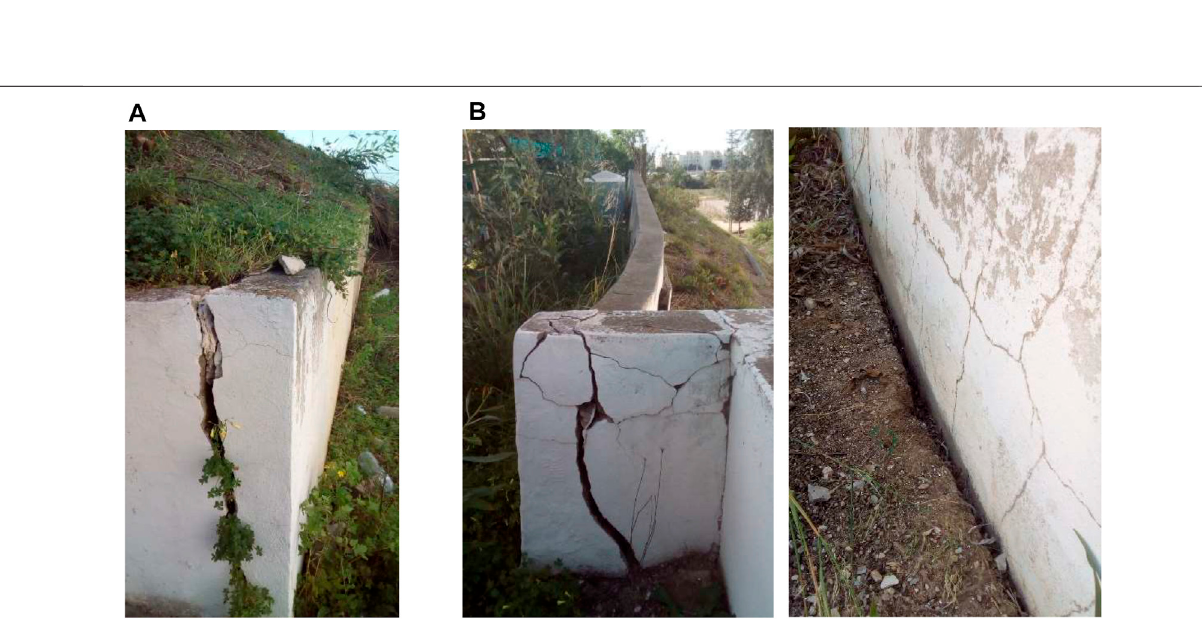
Frontiers in Built Environment |